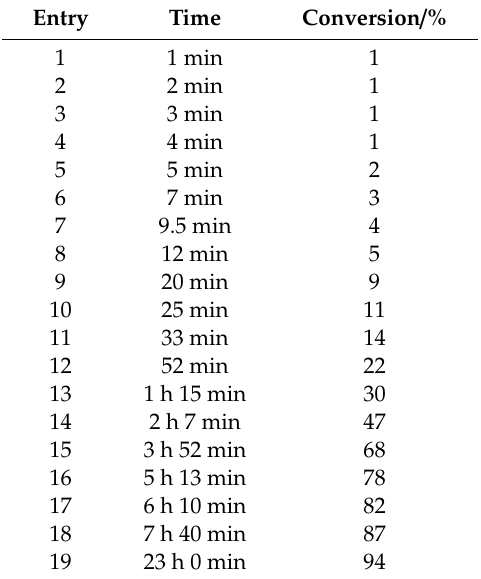
Table A10. Reduction of acetophenone ( 1 ) to 1-phenylethanol ( R )- 2 . Change from standard procedure: 200 mM potassium phosphate bu ff er trial